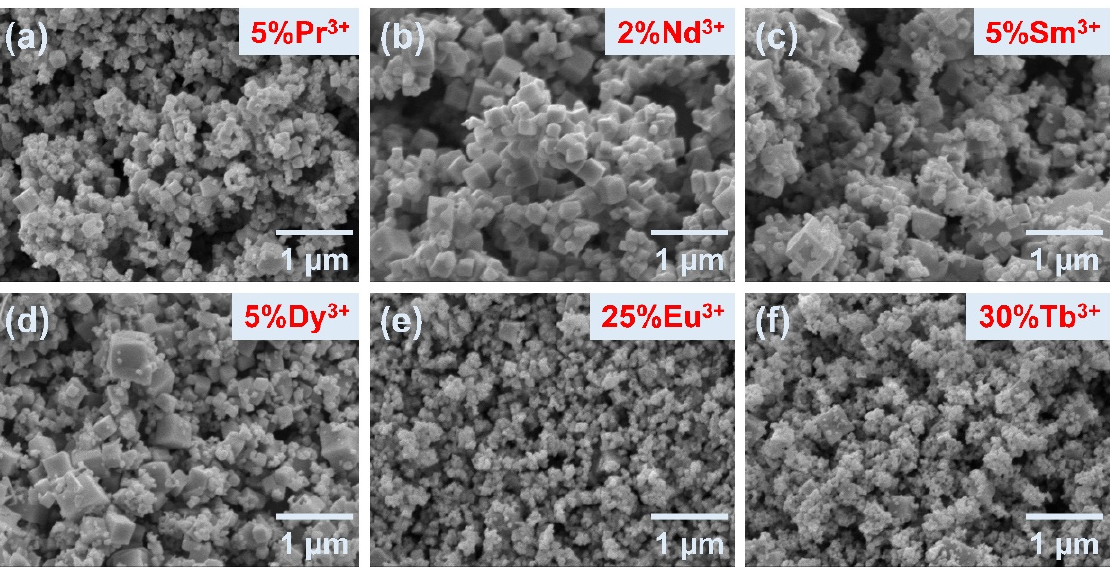
Figure 5. SEM images of the KBF:Ln (Ln = Pr, Nd, Sm, Dy, Eu, and Tb) nanocrystalline particles synthesized at room temperature, introducing ( a ) 5% Pr 3+ ; ( b ) 2% Nd 3+ ; ( c ) 5% Sm 3+ ; ( d ) 5% Dy 3+ ; ( e ) 25% Eu 3+ ; ( f ) 25% Tb 3+ .